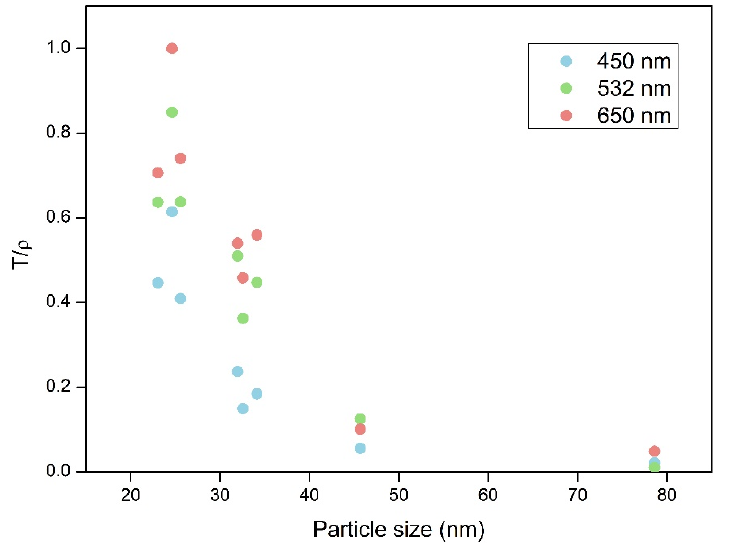
Figure 6. Dependence of normalized transmittance on the particle size of the final aerogels (1 mm thickness).